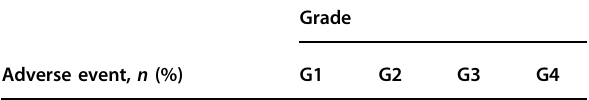
Table 1 Adverse